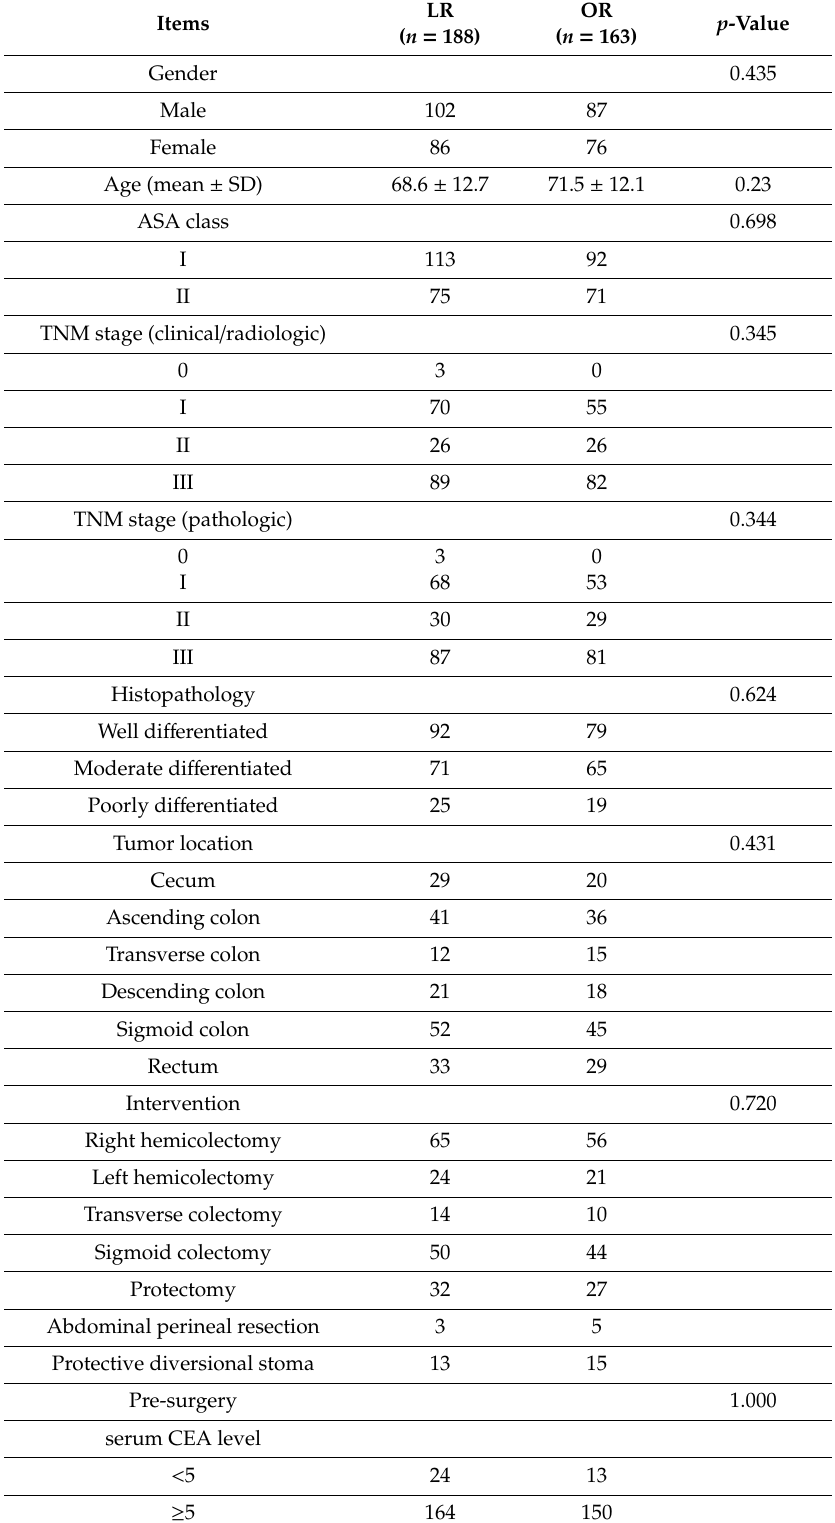
Table 1. Comparison of baseline characteristics between laparoscopic resection (LR) versus open resection